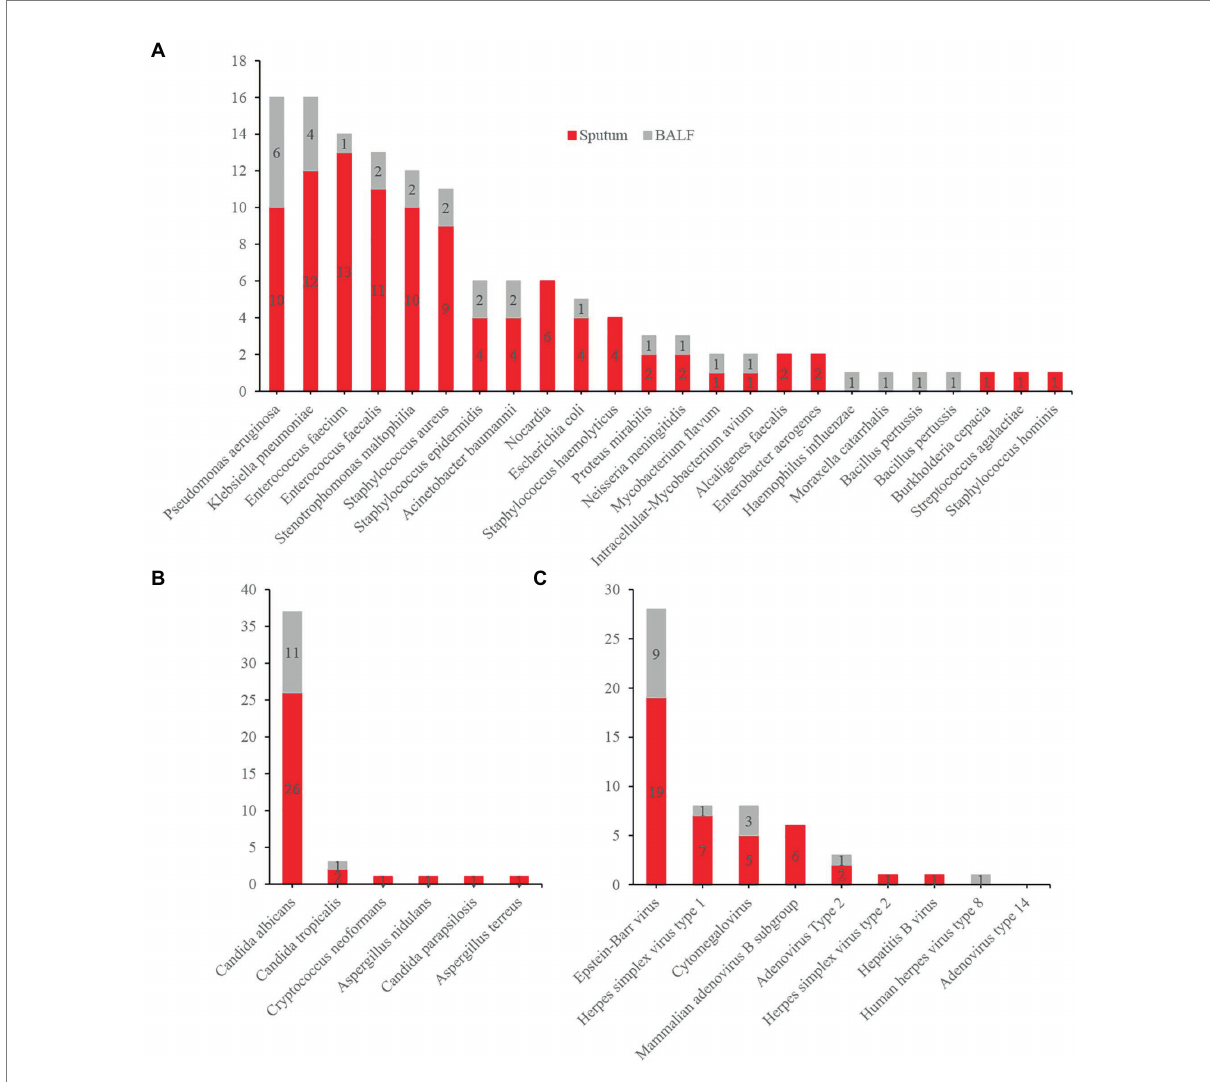
FIGURE 3 Distribution of bacteria (A) , fungi (B) , and virus (C) detected by Chips for Complicated Infection Detection. The most commonly detected bacteria, fungi, and virus are Pseudomonas aeruginosa , Candida albicans , and Epstein–Barr